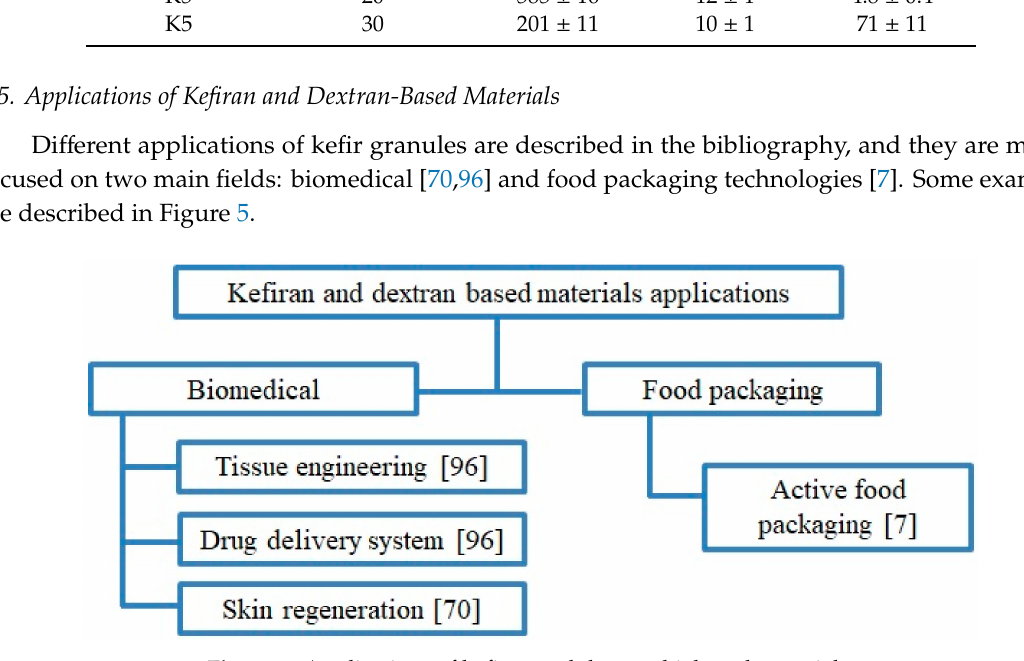
Figure 5. Applications of kefiran and dextran biobased